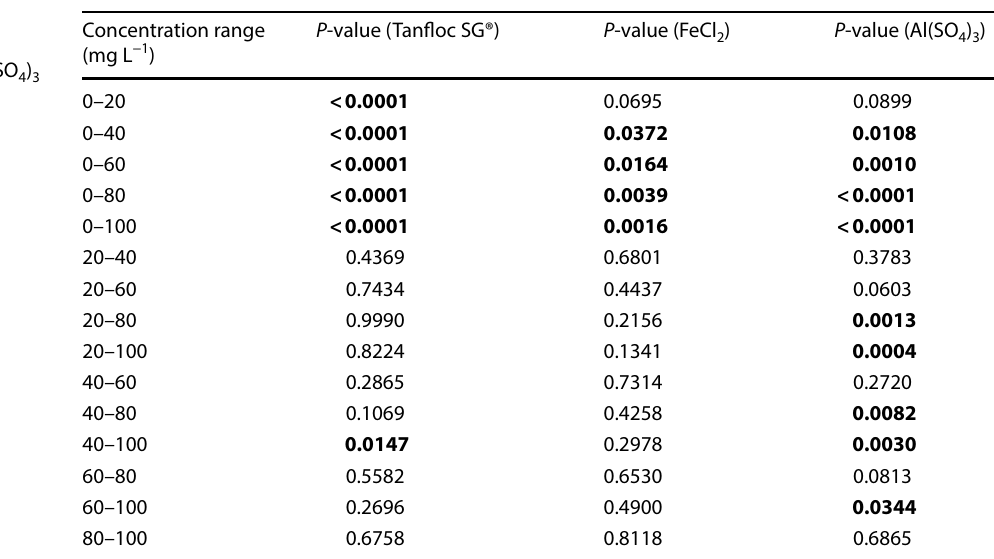
and Al (SO ) 2 2 4 3